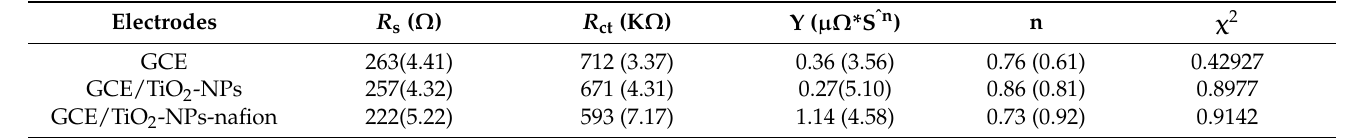
Table 4. Impedance data obtained for electrodes in 47.6 µ M EFV at a fixed potential of 1.2 V (vs. Ag/AgCl, standard KCl). The % errors of the data fitting are shown in